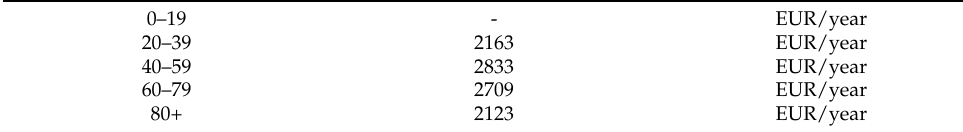
Table A2. VAT revenue per capita per age cohort.